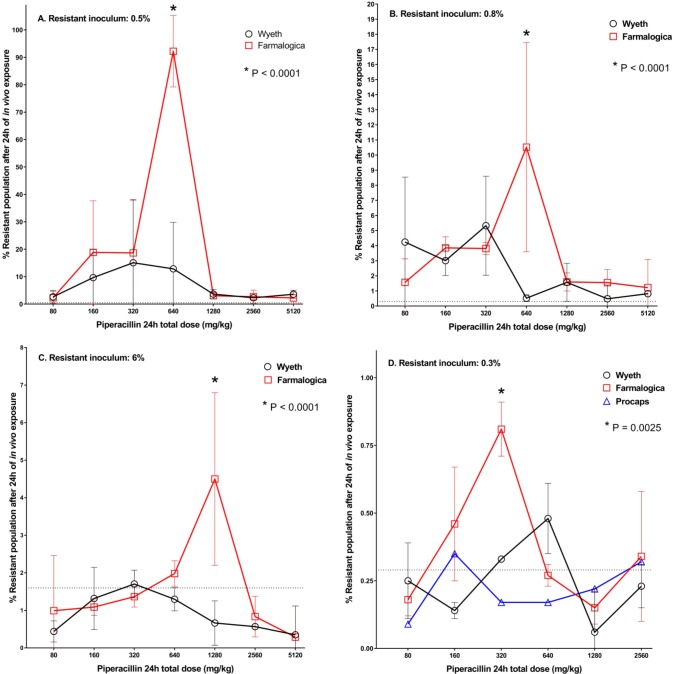
Resistance proportion after in vivo exposure of a mixed E. coli population to innovator (Wyeth) and generic (Farmalogica) TZP.A. Resistant inoculum of 0.5%. At the start of treatment (2 hours after inoculation) the proportion of resistance had dropped to 0.25% (dotted line) and the net growth of the resistant subpopulation in untreated controls reached 2 log10 CFU/g. The generic significantly enriched the resistant subpopulation at 640 mg/kg per day (P<0.0001), without differences at the other doses, in an “inverted U” pattern. The graph shows the weighted mean and standard deviation (wMean and wSD) from 2 independent experiments comprising 5 mice per product per dose. B. Resistant inoculum of 0.8%. At the start of treatment the proportion of resistance had dropped to 0.3% (dotted line) and the net growth of the resistant subpopulation in untreated controls was 0.8 log10 CFU/g. The generic significantly enriched the resistant subpopulation at 640 mg/kg per day (P<0.0001), without differences at the other doses. The graph shows 3 mice per product per dose. C. Resistant inoculum of 6%. At the start of treatment the proportion of resistance dropped to 1.6% (dotted line) and the net growth of the resistant subpopulation in untreated controls was 0.5 log10 CFU/g. The generic significantly enriched the resistant subpopulation at 1280 mg/kg per day (P<0.0001), without differences at the other doses. The graph shows 3 mice per product per dose. D. Resistant inoculum of 0.3%. At the start of treatment the proportion of resistance declined to 0.29% (dotted line) and the net growth of the resistant subpopulation in untreated controls was 1.2 log10 CFU/g. There were no differences between the innovator and the generic Procaps at any dose. The generic Farmalogica, on the other hand, significantly enriched the resistant subpopulation at 320 mg/kg per day (P = 0.0025). The apparent increase in resistance with the innovator at 640 mg/kg per day was not statistically significant after the post-hoc test. The graph shows 2 mice per product per dose.